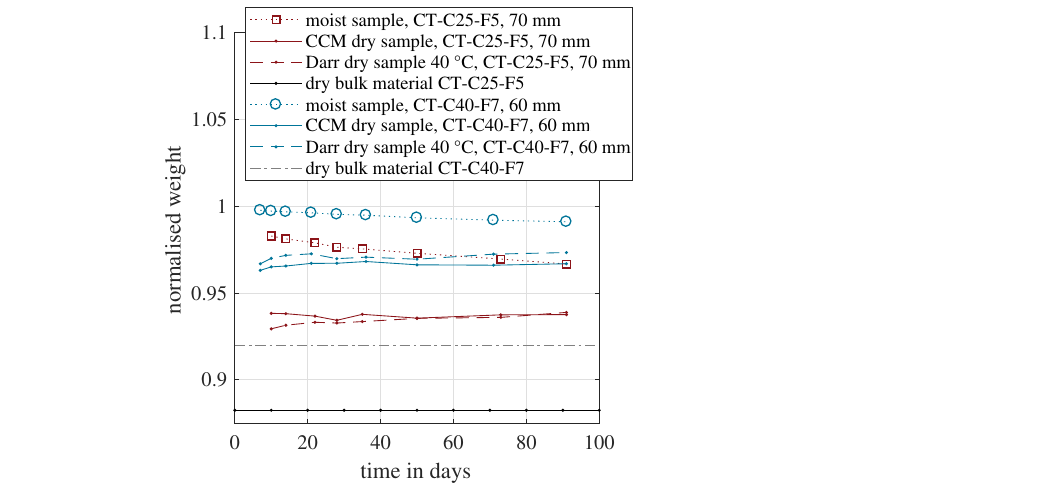
Figure 7. Evolution of the normalised dry weight over time measured for two samples with a cement-based